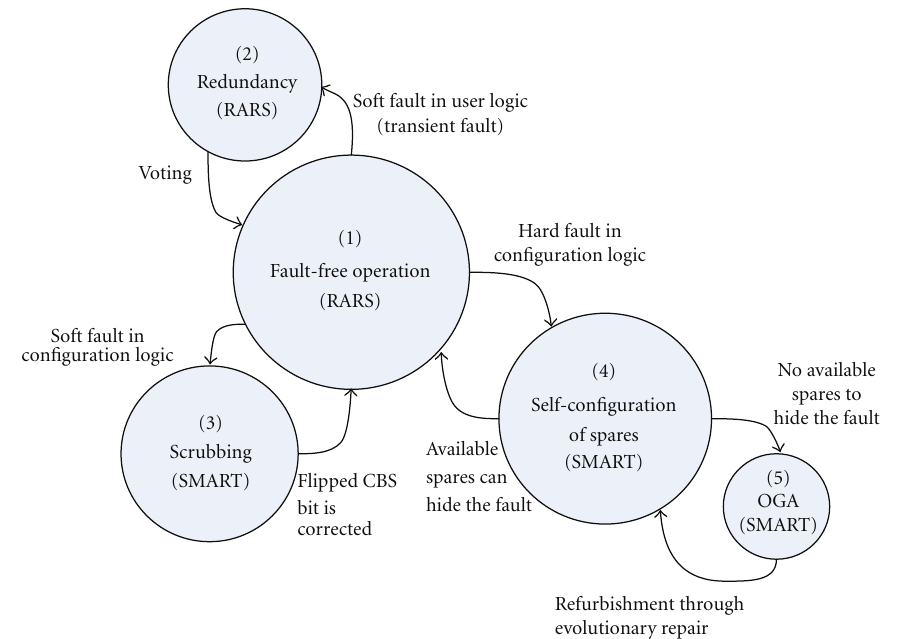
Figure 1: High-level View of SMART’s Repair